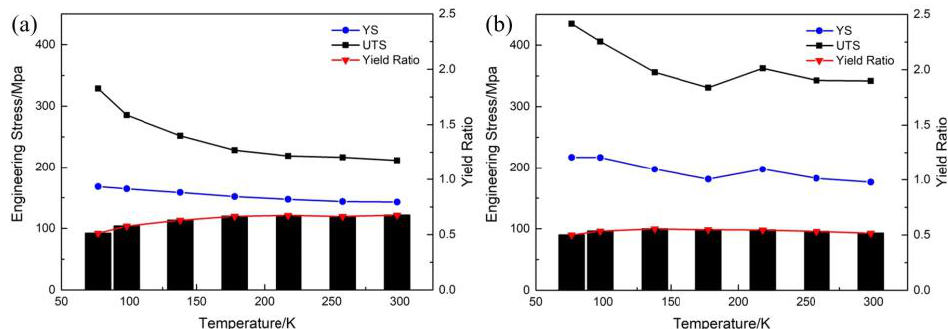
Figure 4. Yield strength, tensile strength, and yield ratio of 2195 alloy at 298 K to 77 K: ( a ) O-state,